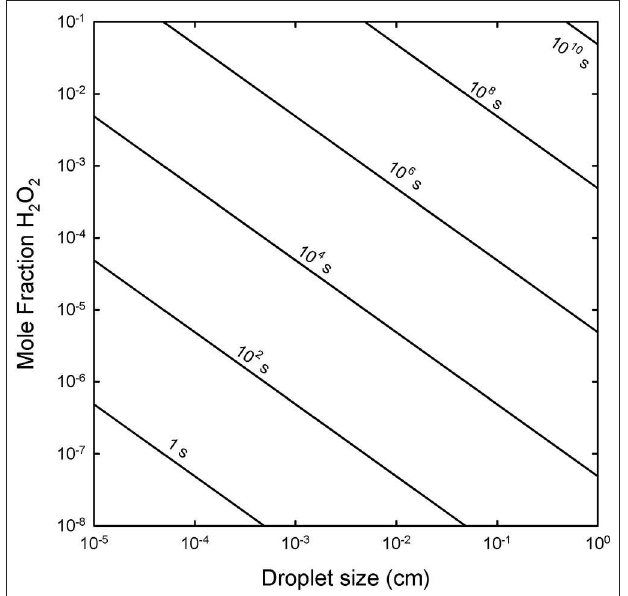
FIGURE 3 | The exposure timescale [in seconds, from Equation (vii)] required to produce a specific mole fraction of H 2 O 2 (y-axis) as a function of droplet size (diameter in cm, x-axis). Note that 1 month is about ∼ 10 6.5 s.